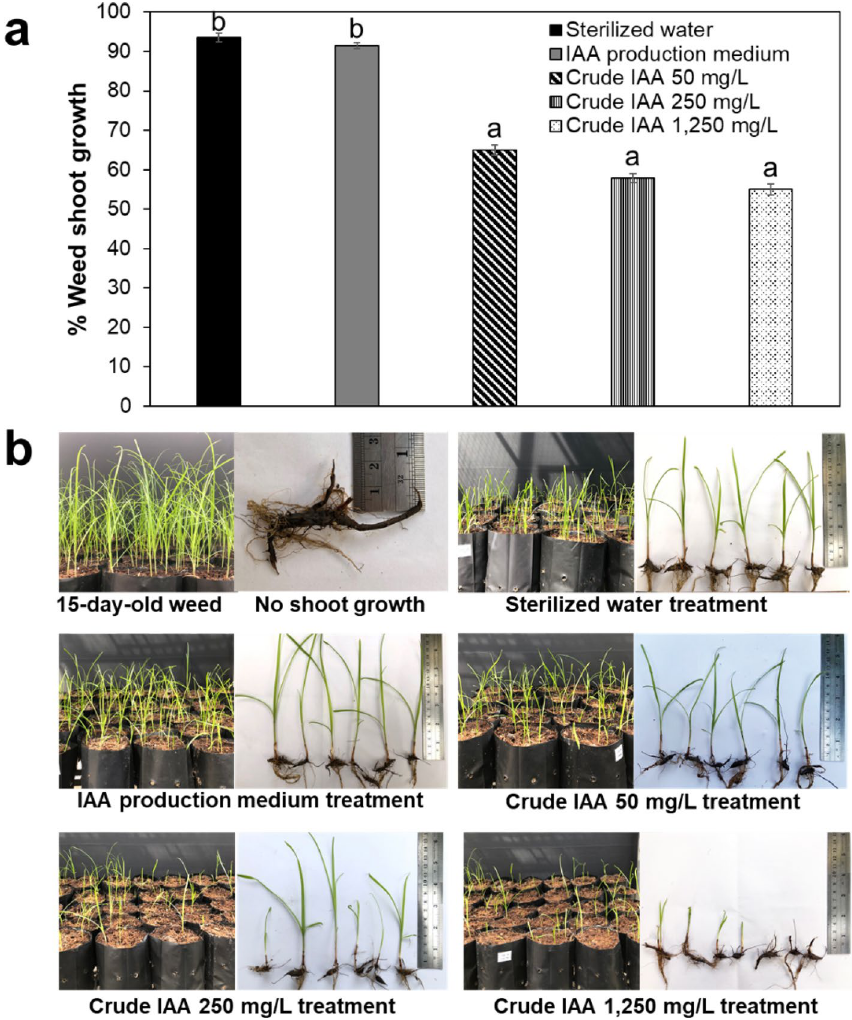
Figure 7. Effect of ( a ) crude IAA produced by R. fluvialis DMKU-CP293 on weed shoot growth and ( b ) weed growth in plastic planting bags in control and crude IAA treatments after 9 days in a greenhouse. Different letters above the bars indicate significant differences between treatments using Duncan’s multiple range test ( p <